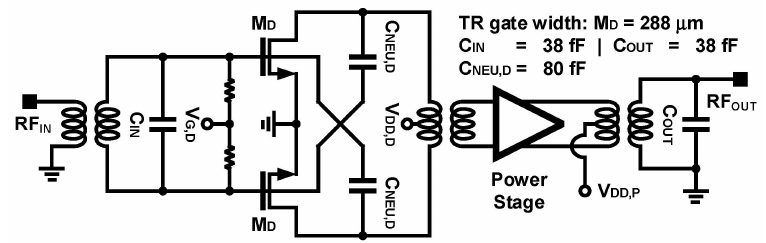
Figure 6. Schematic of the designed